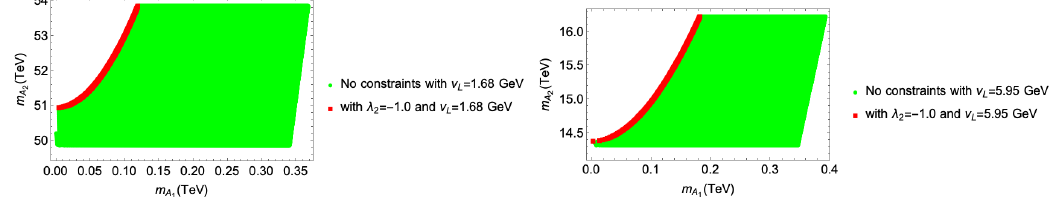
Figure 9 . Parameter space of the pseudoscalar Higgs masses obtained by varying µ 3 , and the dependence λ couplings in the scalar potential, and on the VEV v 2 v L = 5 . 95